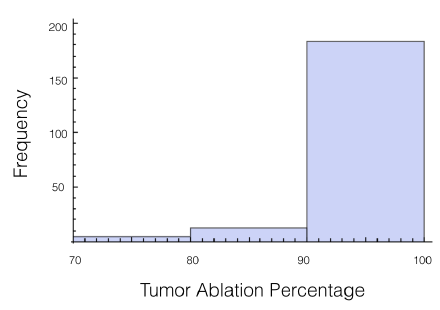
Figure 6. Histogram for percentage of tumor above 700 V/cm for case 2 at 2000